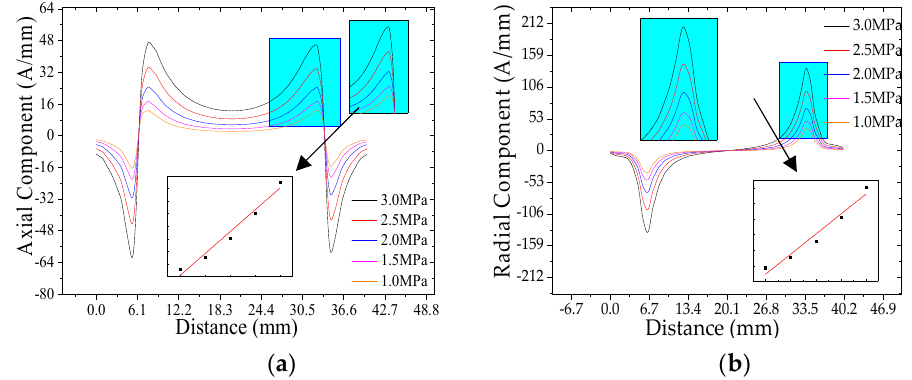
Figure 6. The weak magnetic signal of pipeline crack with different internal pressures: ( a ) axial component and ( b ) radial component. The axial maximum and the radial peak of the weak magnetic signal at the crack are extracted, and the relationship between the signal and the internal pressure is shown in the figure.